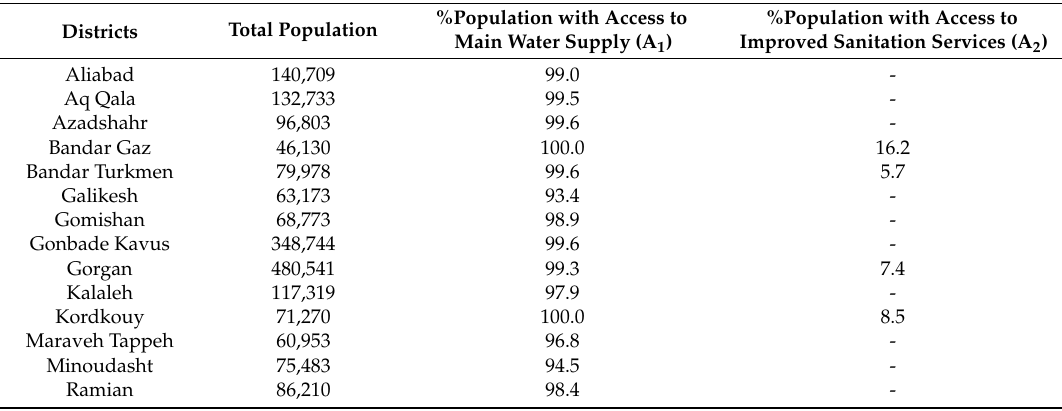
Table 4. The status of the “Access” component in different districts of Golestan Province. Districts